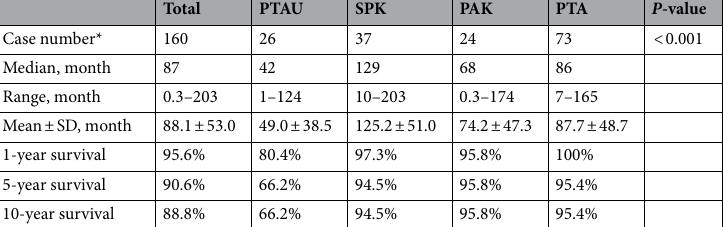
Table 3. Survivals for patients after pancreas transplant. PTAU pancreas transplant alone in uremic patients, SPK simultaneous pancreas and kidney transplant, PTA pancreas transplant alone, PAK pancreas after kidney transplant, *Surgical mortality was